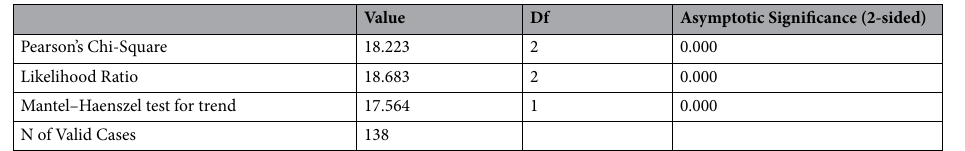
Table 2. Results of a Chi-square test of independence for different age groups (pre-kindergarteners, schoolers, and students) and type of video estimated as longer in duration.